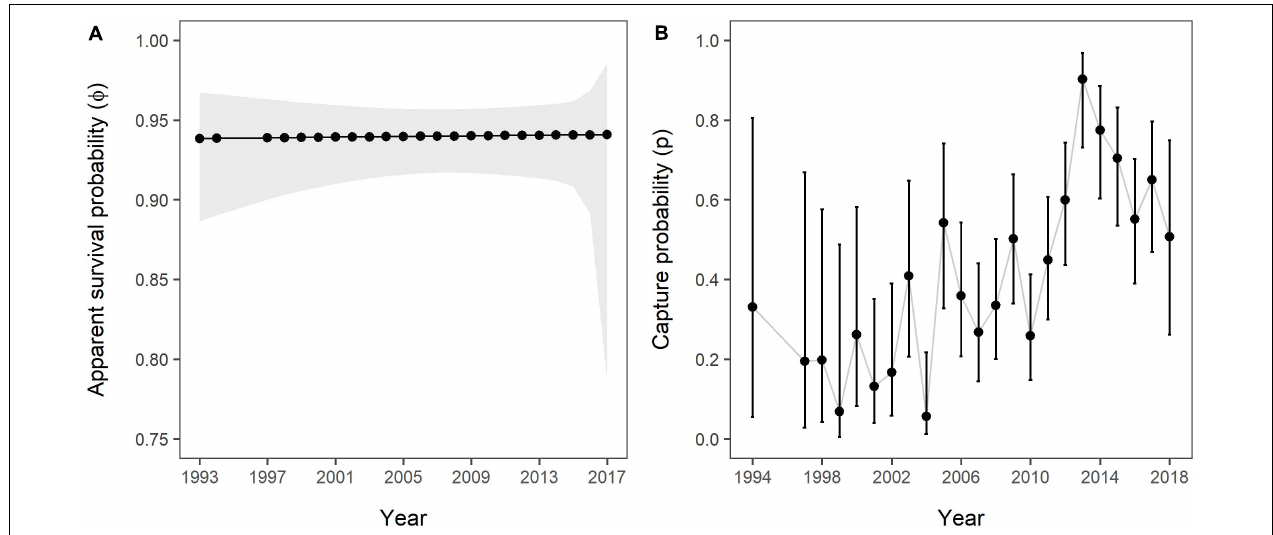
FIGURE 5 | (A) Apparent survival and (B) capture probabilities over the study period as estimated by the Overall Survival model, including all 141 individuals and no grouping variable. The grey polygon (A) and error bars (B) represent 95% confidence intervals. No estimates were obtained for 1995 and 1996 due to a lack of data.